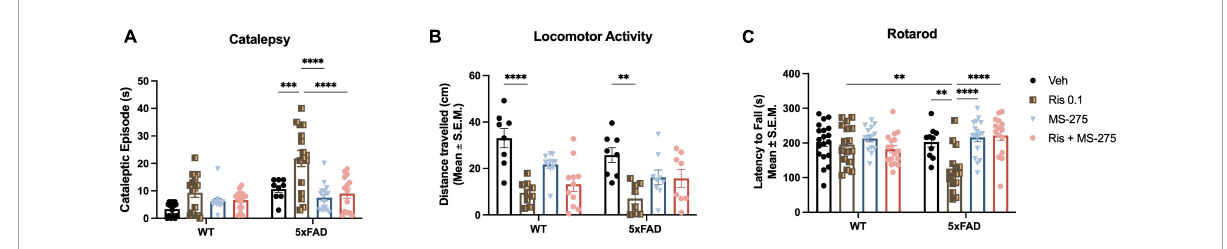
FIGURE2 Risperidone induces motor side effects in 5xFAD mice and histone deacetylase (HDAC) inhibitor could prevent the side effects. (A) Lower dose of RIS (0.1 mg/kg) induced the cataleptic episode in 5xFAD but not wild type (WT) mice at 12 months of age. Co-treatment of RIS with MS-275 significantly reduced cataleptic episodes of 5xFAD mice. (B) RIS induced reduced general locomotor function in both WT and 5xFAD mice measured by the distance traveled in the open field. However, co-treatment of RIS with MS-275 did not improve general locomotor activity. (C) RIS also effected on motor coordination in 5xFAD mice but not WT controls by decreasing the latency to fall measured the rotarod. Co-treatment of RIS with MS-275 significantly improved motor coordination. Data represent mean ± SEM ( n = 8–19/group). ∗∗ p < 0.01, ∗∗∗ p < 0.001, ∗∗∗∗ p <